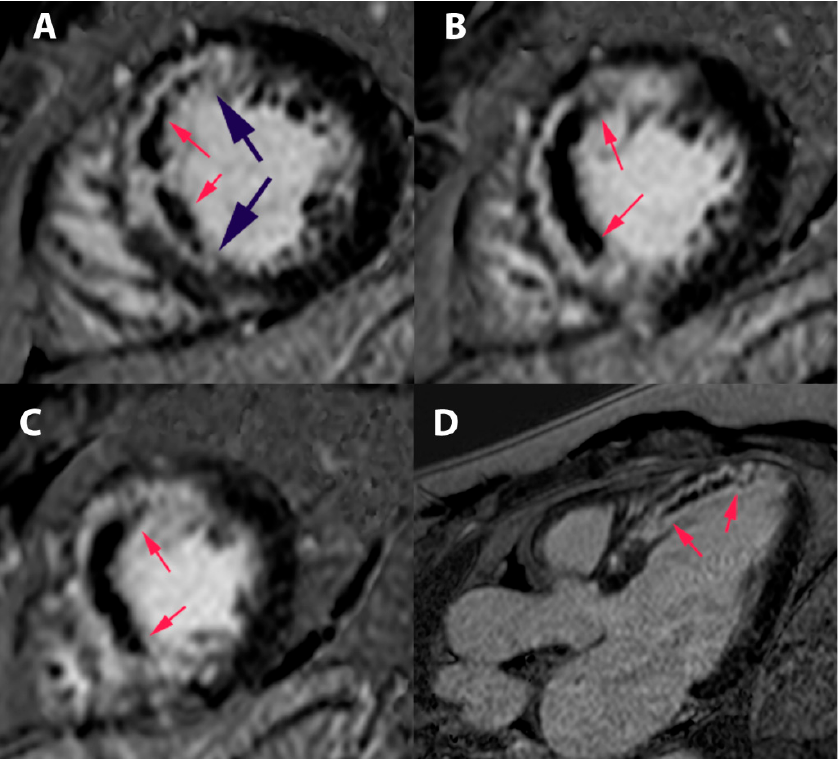
Figure 13. Cardiac resonance magnetic (CRM) showing delayed enhancement on left ventricular images: ( A ) short axis (base); ( B ) short axis (medium); ( C ) short axis (apical); and ( D ) long axis of the left ventricular outflow tract. Black arrows indicate anteroseptal myocardial infarction area of the left ventricle (white area). Red arrows indicate no reflow (microvascular obstruction) image.